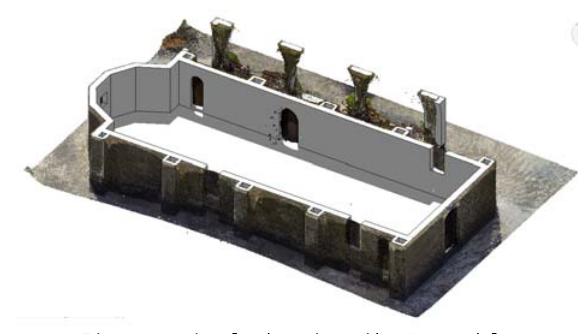
Figure 9. Point cloud section with BIM model